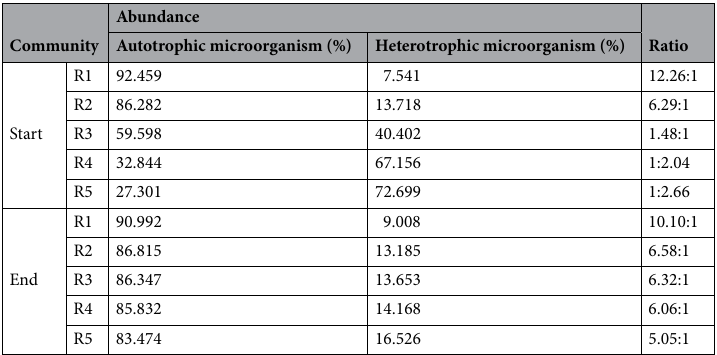
Table 2. The abundance of autotrophic micro-organism and heterotrophic microorganism. Consortia with algae/sludge 10:1, 5:1, 1:1, 1:5 and 1:10 (donated as R1 to R5). Start (the operation start-up, the 0 h) and End (the operation end, the 48th